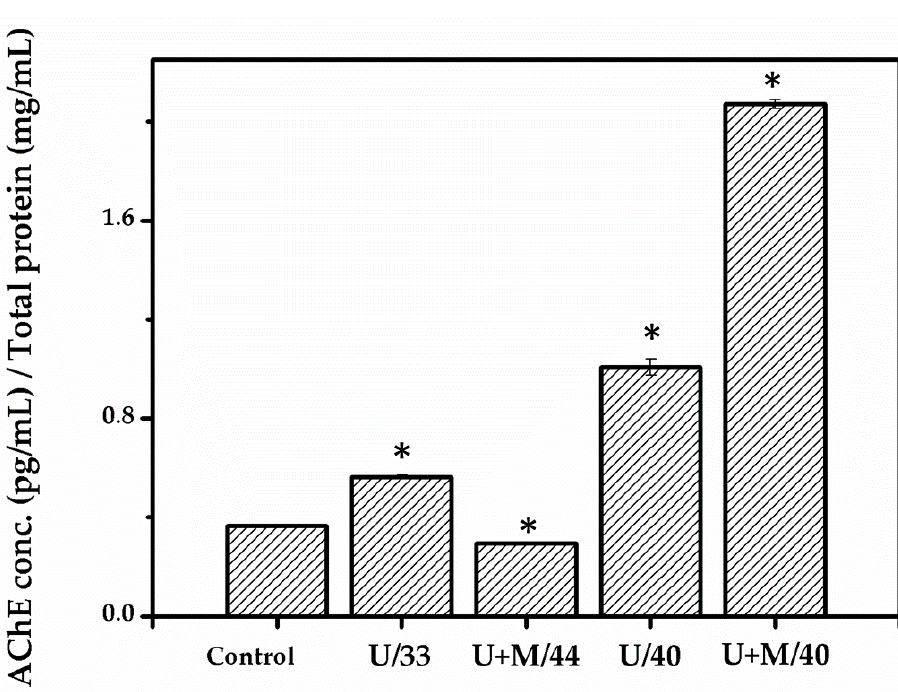
Figure 6. Measurement of acetylcholinesterase (AChE) activity. Non-treated cells are designated as control, U/33 is ultrasound-treated cells at 33 °C, U+M/44 is ultrasound-treated cells combined with warming biomaterial at 44 °C, U/40 is ultrasound-treated cells at 40 °C, U+M/40 is ultrasound-treated cells combined with warming biomaterial at 40 °C. * p < 0.05 compared with control group.